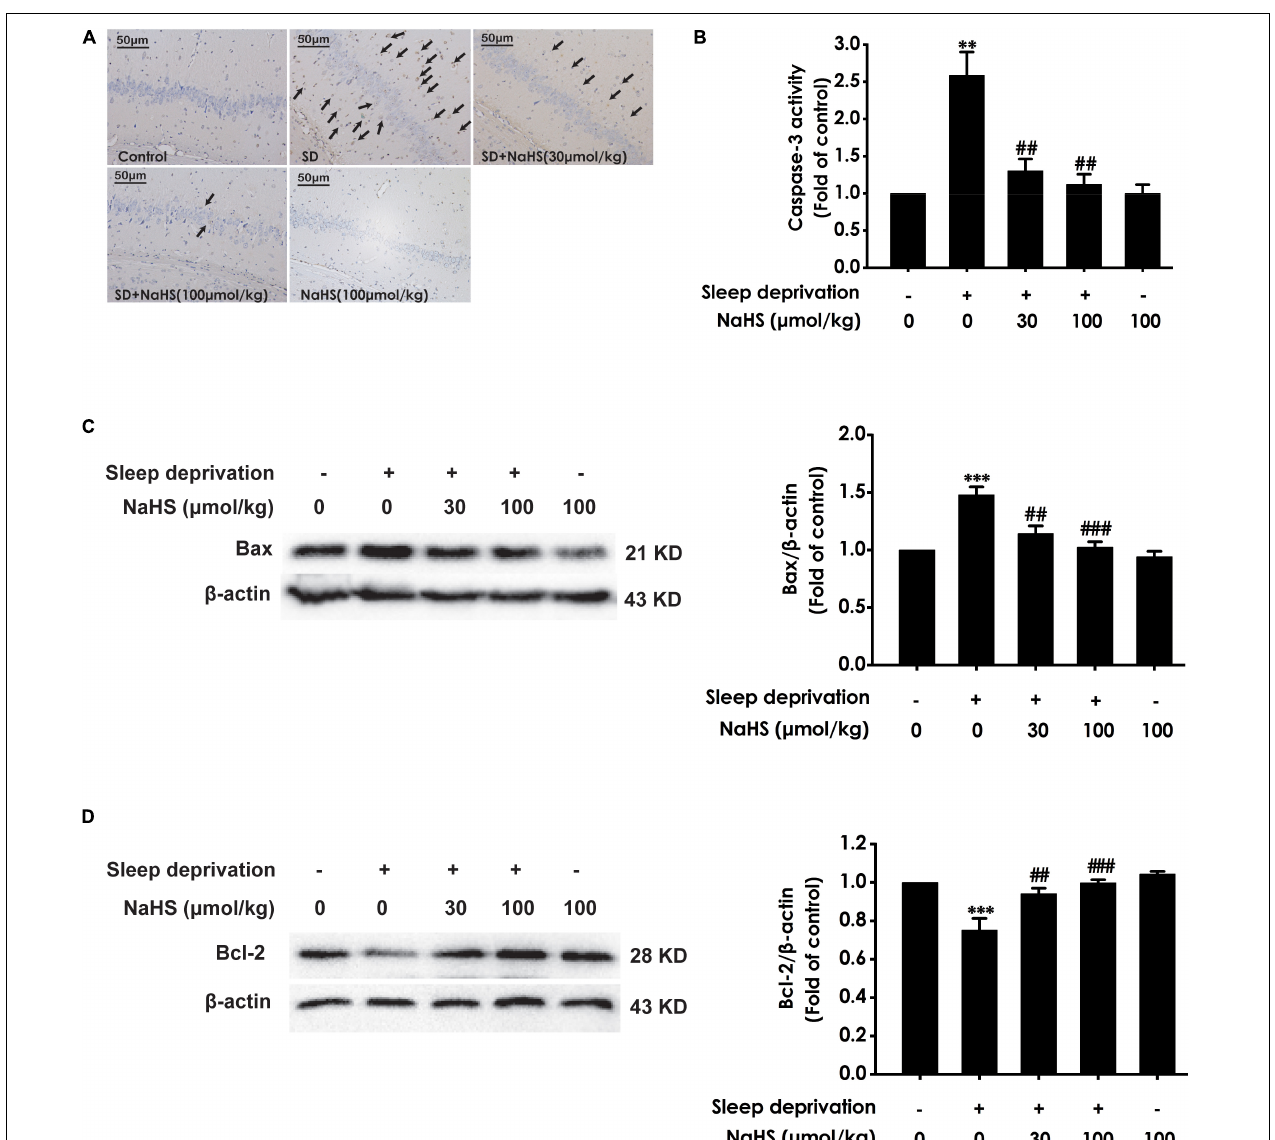
FIGURE 3 | Effect of hydrogen sulfide on sleep deprivation-induced hippocampal apoptosis in rats. Rats were pretreated with NaHS (30 and 100 µ mol/kg/d, ip) for 7 days and then cotreated with SD for 72 h. The apoptotic cells in the CA3 area of hippocampus (A) were assessed using Tunel staining, and the arrows indicate the apoptotic cells. The activity of caspase-3 (B) in the hippocampus was detected by ELISA kits. The expressions of Bax (C) and Bcl-2 (D) in the hippocampus were detected by western blot using anti-Bax antibody and anti-Bcl-2 antibody, respectively. In all blots, β -actin was used to determine control. Values are the mean ± S.E.M. ( n = 3–4), ∗∗ P < 0.01, ∗∗∗ P < 0.001 vs. control group. ## P < 0.01, ### P < 0.001, vs. SD-treated alone